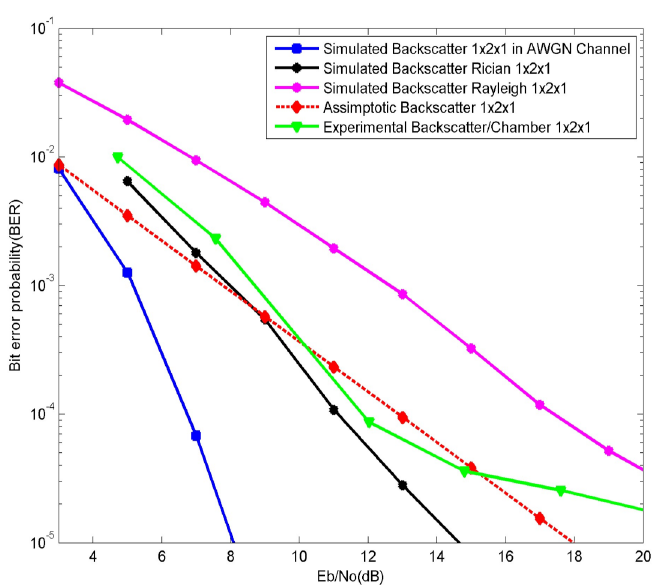
Figure 11. The BER results of a 1 × 2 × 1 system. Theoretical, simulated, and experimental results, K f and K b =